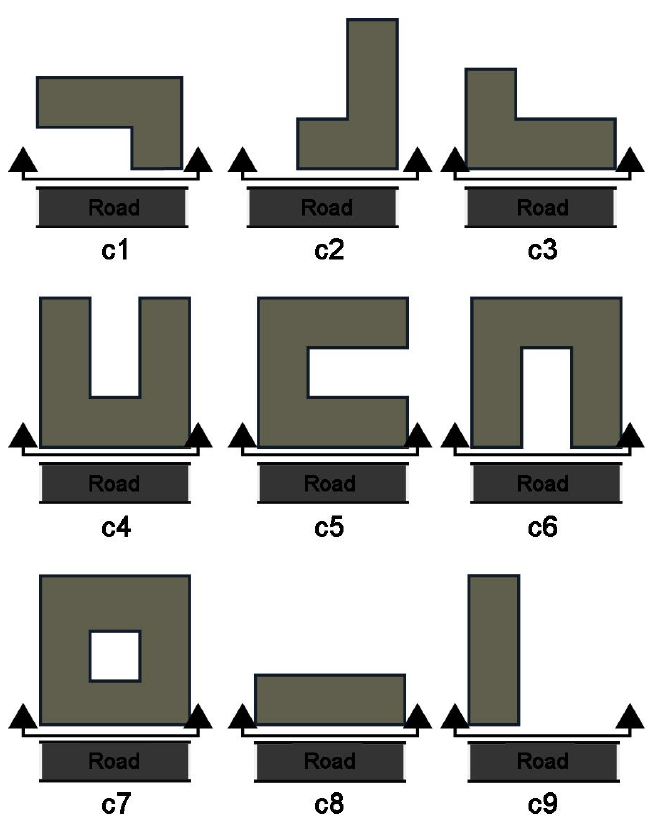
Figure 6. Orientation of the road (C) Reprinted/adapted with permission from Ref. [3]. 2018, Donghwa Shon: Even in the same Hanok, the facade varies depending on the direction facing the road.